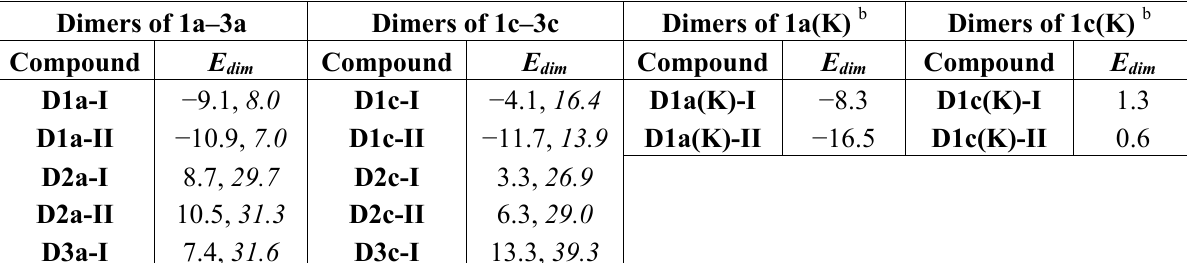
Table 5. Reaction energies (kcal/mol) for formation of dimers of silaphenolates calculated at the M062X/6-311G(d)//M062X/6-31G(d) (normal) and B3LYP/6-31G(d) (italics) levels a